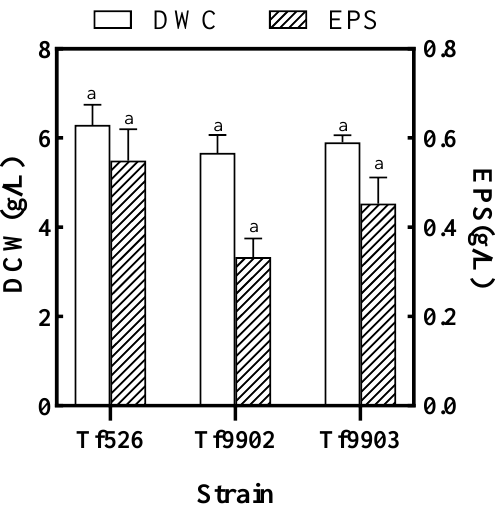
Figure 1. Microscopic observation of three strains of Tremella fuciformis ( Tf526 , Tf9902 , Tf9903 ) on the solid culture plate. ( a ) Front view of Tremella fuciformis ( Tf526 , Tf9902 , Tf9903 ) on a culture plate. ( b ) Back view of Tremella fuciformis ( Tf526 , Tf9902 , Tf9903 ) on a culture plate. ( c ) Mycelium micro exam-